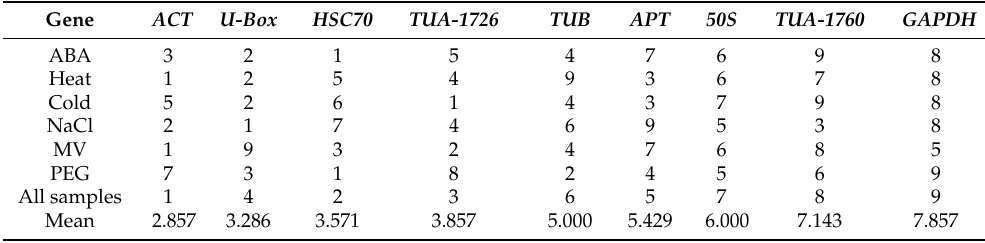
Table 4. Expression stability ranking of 9 candidate genes in all stressed samples analyzed using the geometric mean method in RefFinder.